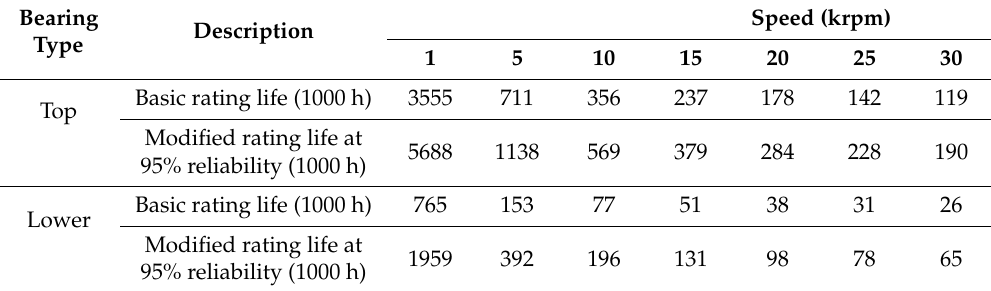
Table 5. Results of bearing life